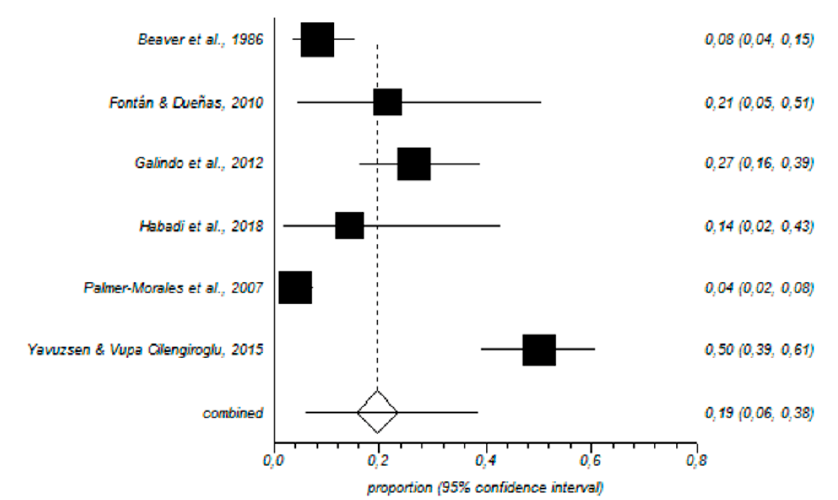
Figure 3. Forest plot for high depersonalization.